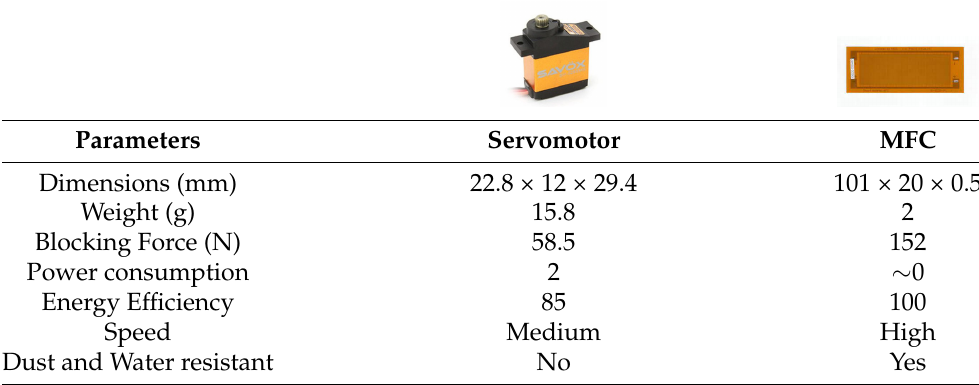
Table 1. Comparison between Servomotors and Macro Fiber Composites (MFC)